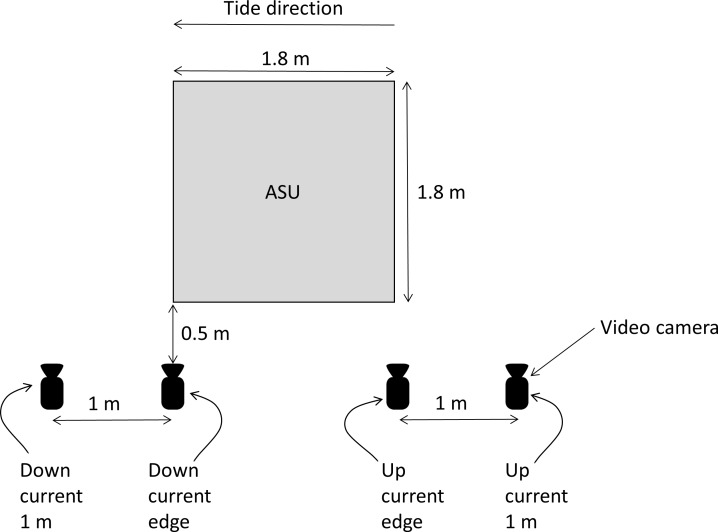
Aerial view layout of video cameras positions used to film post–settlement snapper associated with an ASU.Camera position naming indicated for just one water flow direction. Camera naming reverses on the opposing tidal direction. No camera deployments encompassed a change in tidal direction.